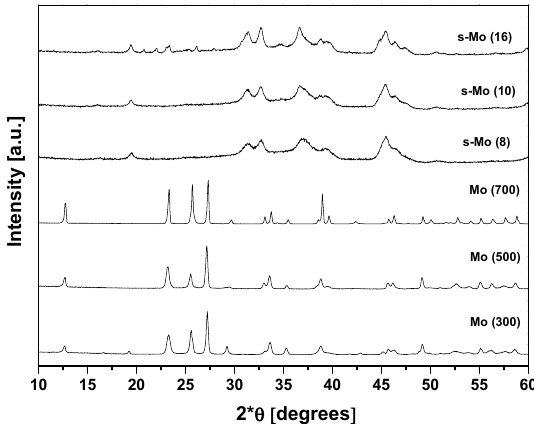
Figure 1. X-ray diffraction (XRD) patterns of the bulk molybdenum catalysts (Mo) calcined at 300, 500, and 700 °C, and of the alumina-supported ones (s-Mo) containing 8, 10 and 16 wt.% MoO 3 and calcined at 800 °C.